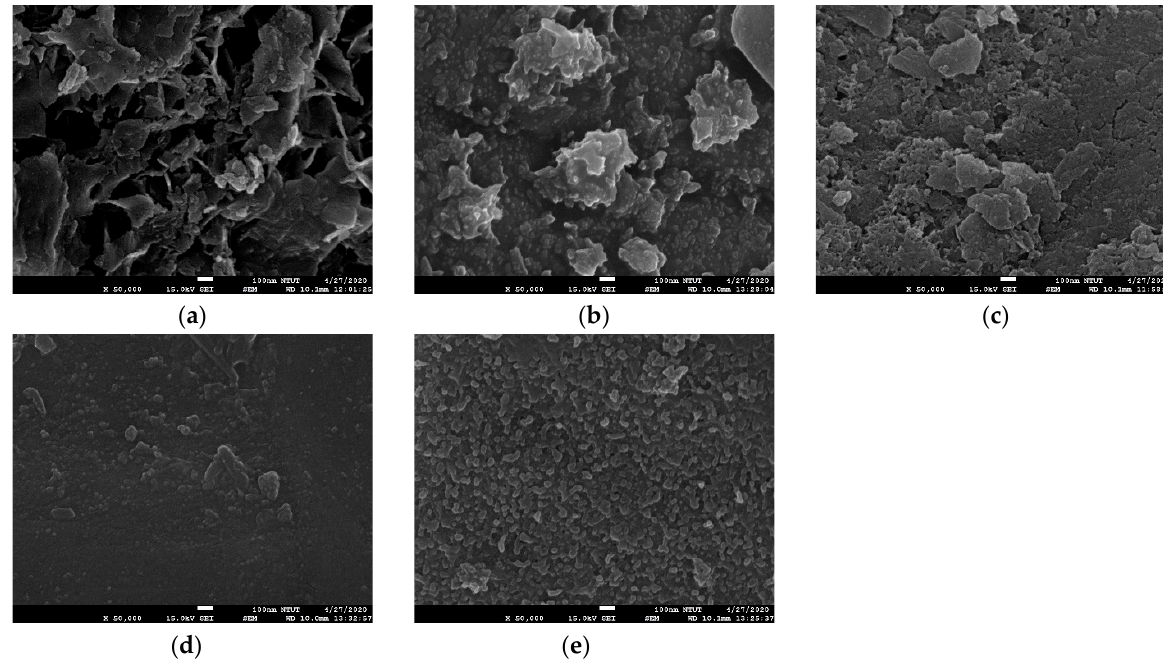
Figure 3. FESEM images showing the surface morphologies of the Mn-Ni-O electrodes. Samples ( a – e ) denote the samples with electroplating Mn:Ni ratio of 1:0, 1:0.25, 1:0.67, 1:4, and 0:1 respectively.